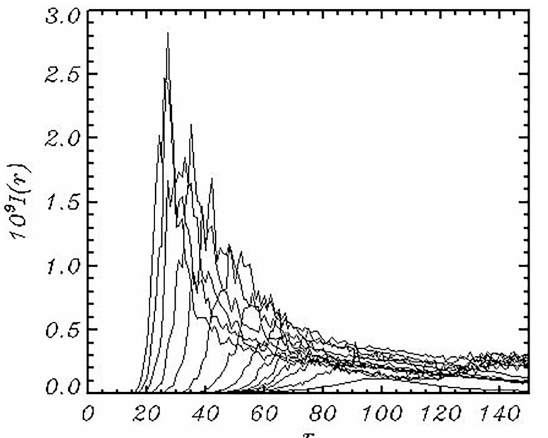
Figure 9. The breaking dissipation spectra D b (r) integrated over angle ψ in the polar coordinates and averaged over the consequent intervals of length for about 100 units of the nondimensional time t